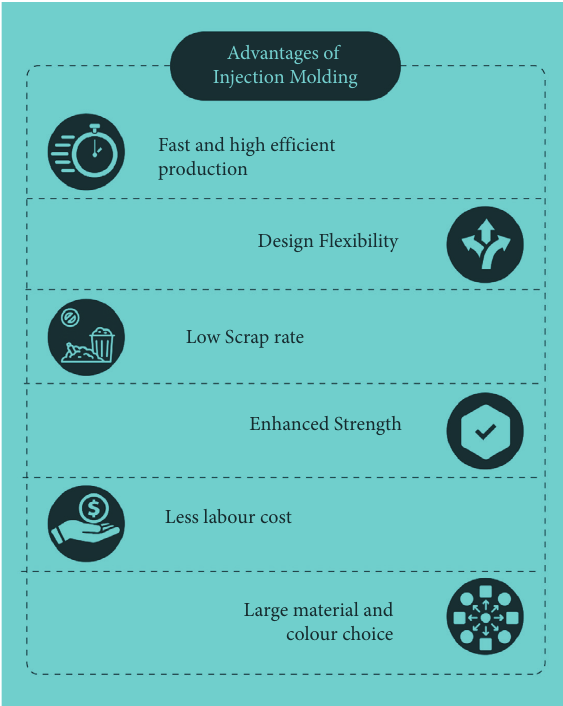
Figure 5: Advantages of injection